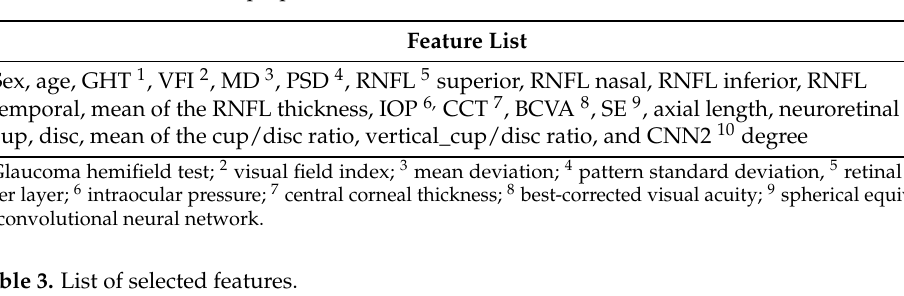
Table 2. Feature list for the prepared dataset.